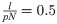
LR during the flushing phase from increased supply duration and reduced EOA, separately.The LR during flushing attributable to increased supply duration (thick black line and square dot), and due to the necessitated reductions in EOA (colored dashed curves), each plotted separately. Three levels of allowable leakage increases are shown: no increase (pink/upper curves), a 50% increase in physical losses (i.e., lpN=0.5) (green/middle curves, and circle), and a 100% increase in physical losses (blue/lower curve). Final durations of 15, 21, and 23.75 hrs/day are shown in the top (a), middle (b), and bottom (c) panels, respectively. The text’s example utility is also shown (square and circle).